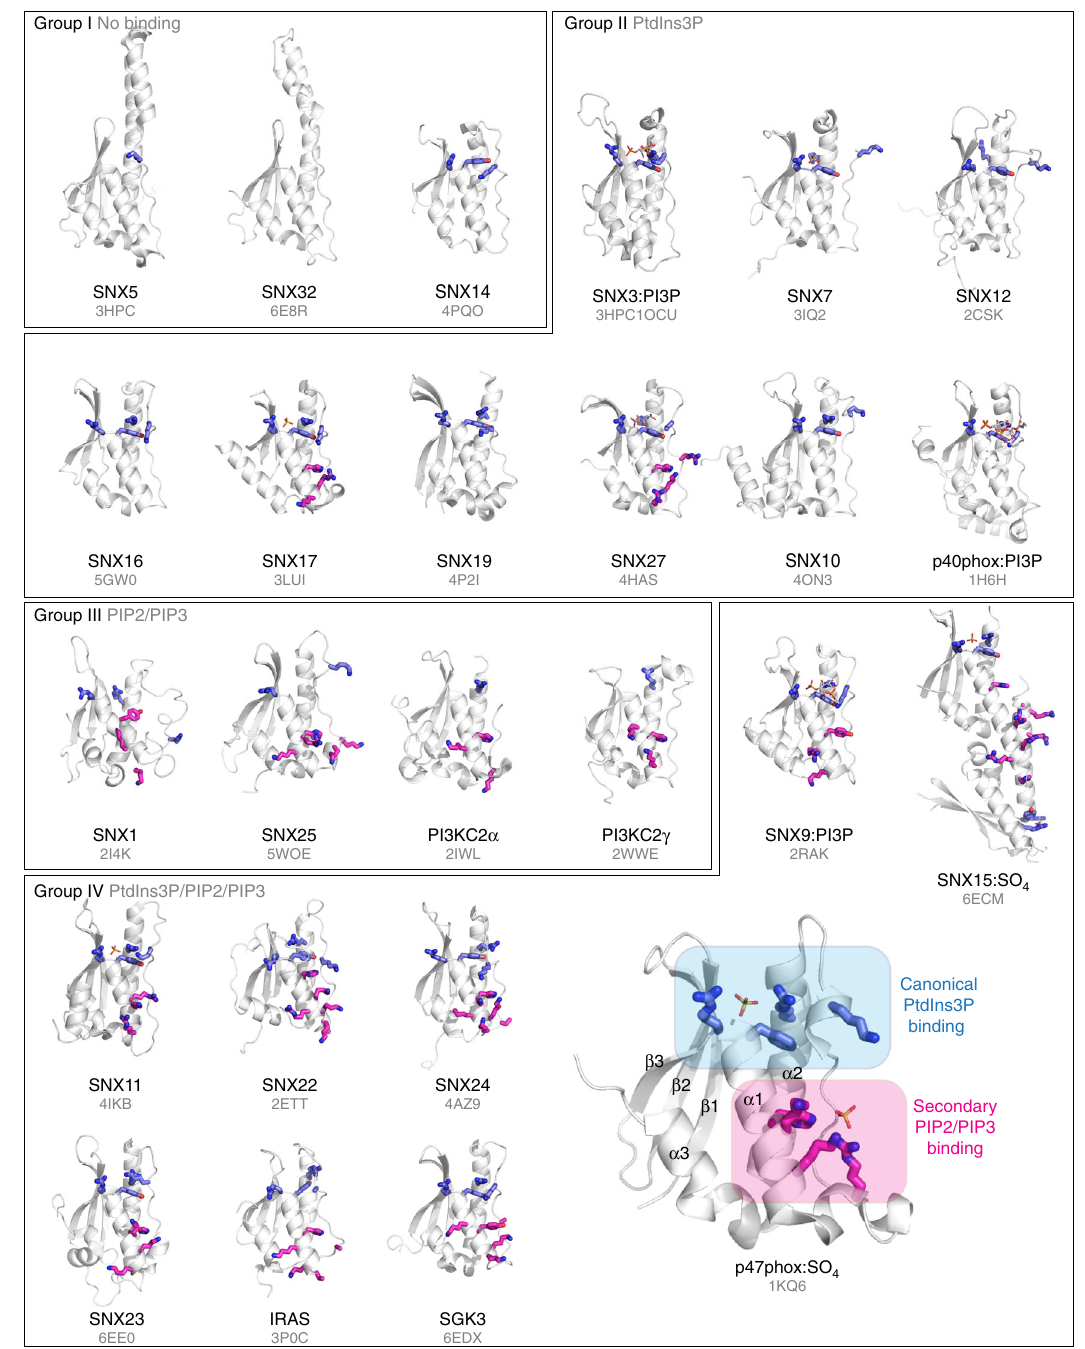
Fig. 3 Known crystal and NMR structures of the PX domains. PX domains with known X-ray crystal or NMR structures are all shown in the orientation using a white cartoon representation. They are grouped according to their phosphoinositide-binding preferences (Fig. 2a). Known ligands including PtdIns3 P and SO 4 2 − ions are shown in stick representation. Side-chains that are required for coordinating PtdIns3 P in that canonical binding site are shown in blue with thick bonds. Shown in magenta are conserved His or Tyr side chain present in the α 1 helix, and adjacent basic residues that together form a putative secondary binding site for alternative phosphoinositides. A sequence alignment highlighting these residues is shown in Fig.